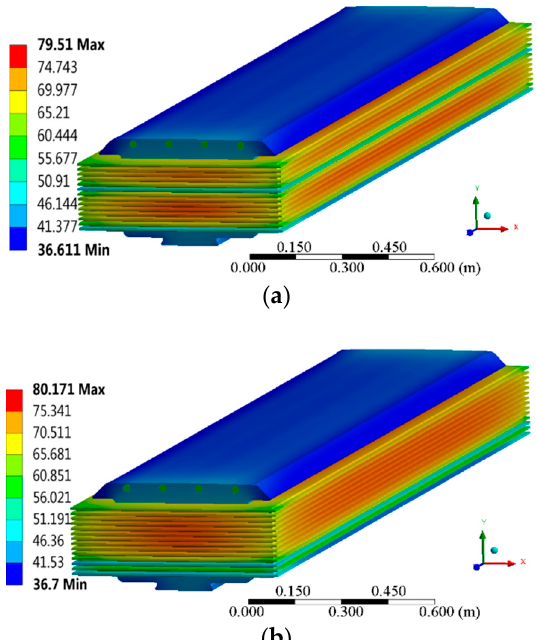
Figure 6. Rotor pole temperature field of one-turn short circuit of rotor winding: ( a ) inter-turn fault of No. 6; and ( b ) inter-turn fault of No.